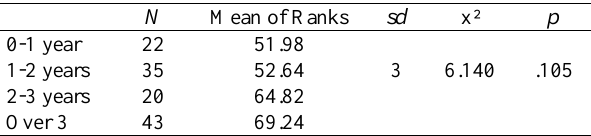
Table 3 Analysis of the Kruskal Wallis-H test results in the ‘length of the students’ possession of a smartphone’